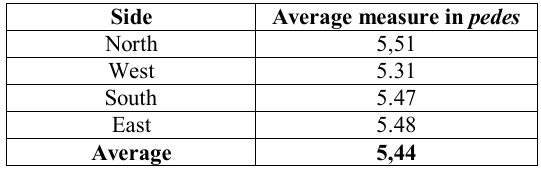
Table 2. Centre to centre distances of Golden Court columns.